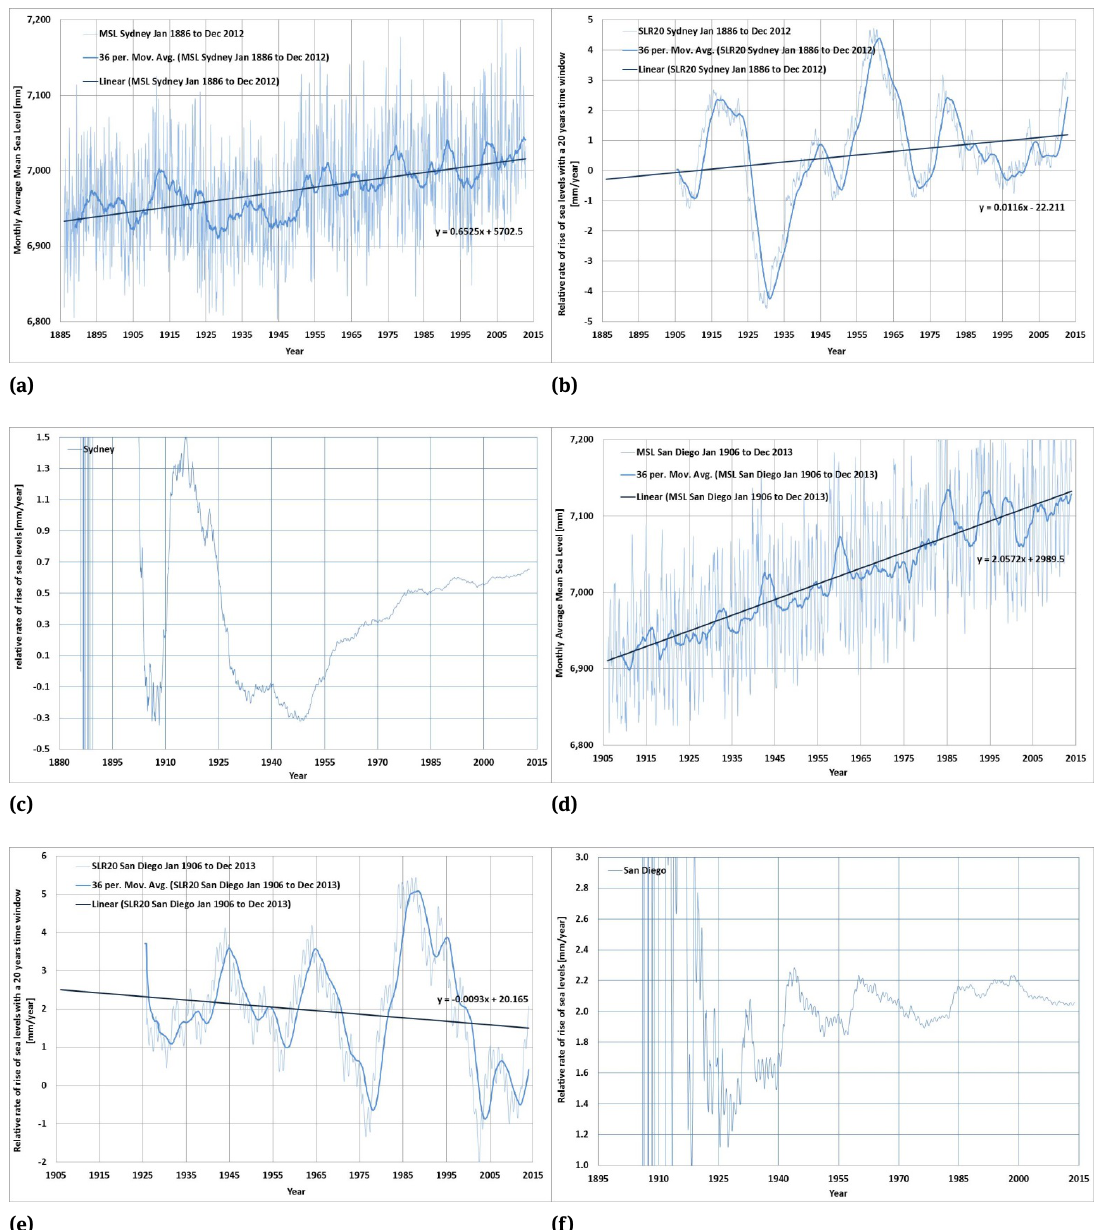
Fig. 1. Classical determination of the relative rate of rise by linear fitting in two tide gauges of the Pacific, Sydney and San Diego, with multi- decadal oscillations not phased. In one tide gauge, the rate of rise is marginally rising and in the other the rate of rise is marginally reduc- ing. The short term tide window is misleading in both locations, showing relative rates of rise much larger or smaller than the true values. SLR20 is the relative rate of rise computed by using a 20 years’ time window. The vertical velocity of the SONEL GPS dome nearby the Syd- ney tide gauge (SYDN) is − 0.89 mm/year while the vertical velocities of the two SONEL GPS dome nearby the San Diego tide gauge (PLO3 & PLO5) are − 1.65 & − 3.23 mm/year. In both cases the subsidence accounts for the most part of the relative sea level